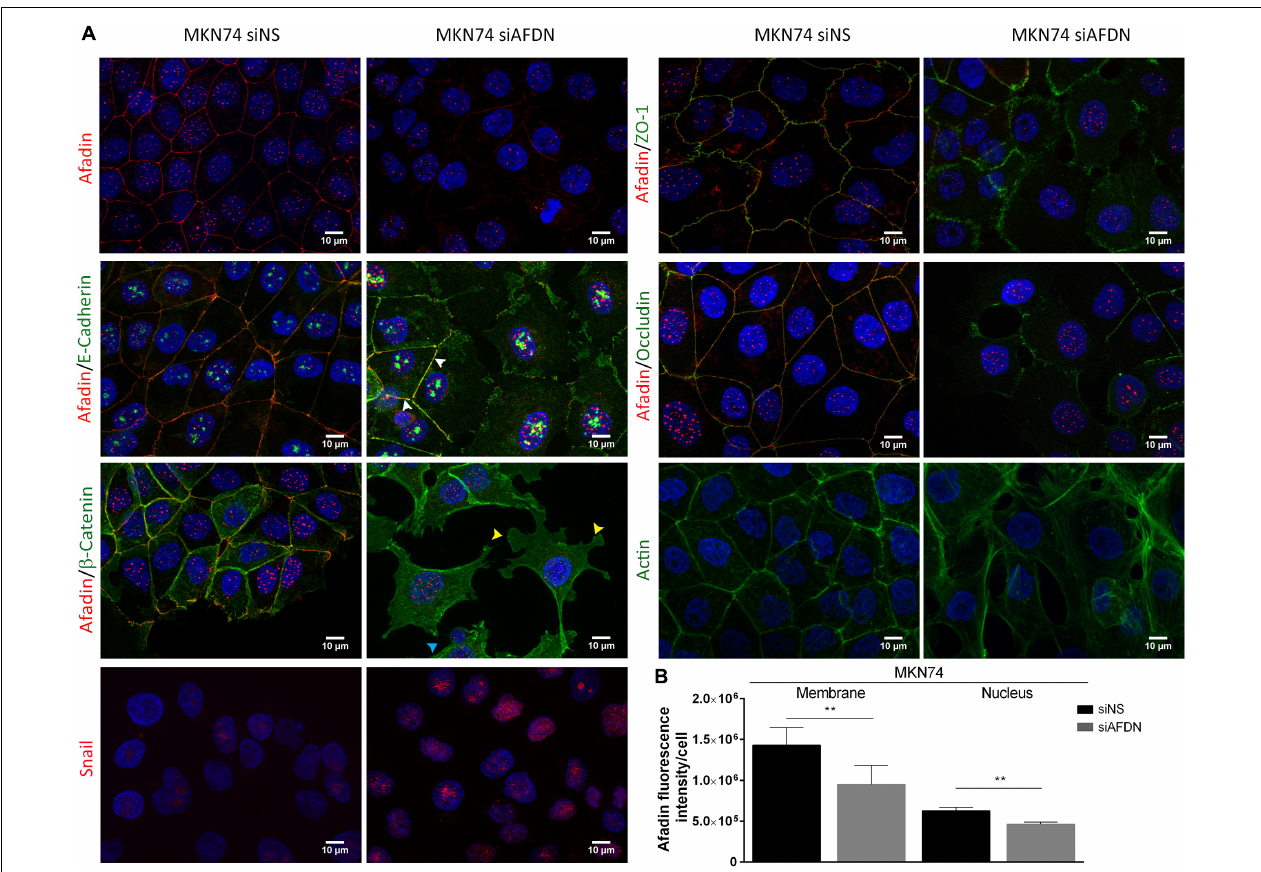
FIGURE 3 | Afadin downregulation displaces apical junctional complex proteins and promotes the formation of actin stress fibers. Double immunofluorescence of Afadin (red) with AJs proteins E-cadherin and β -catenin (green), and with TJs proteins ZO-1 and occludin (green) in MKN74 cells transfected with a non-silencing siRNA (siNS) or with a siRNA to Afadin (siAFDN). Immunofluorescence of actin (green) and of Snail (red) are also shown. Nuclei were counterstained with DAPI. Scale bar, 10 µ m. White arrows represent cells with Afadin not efficiently silenced by the siRNA and that retain the epithelial morphology; Yellow arrows, lamellipodia; cyan arrows, filopodia (A) . Quantification of Afadin fluorescence intensity in MKN74 cells in both membrane and the nucleus upon treatment with non-silencing siRNA or with a siRNA to Afadin (B) .